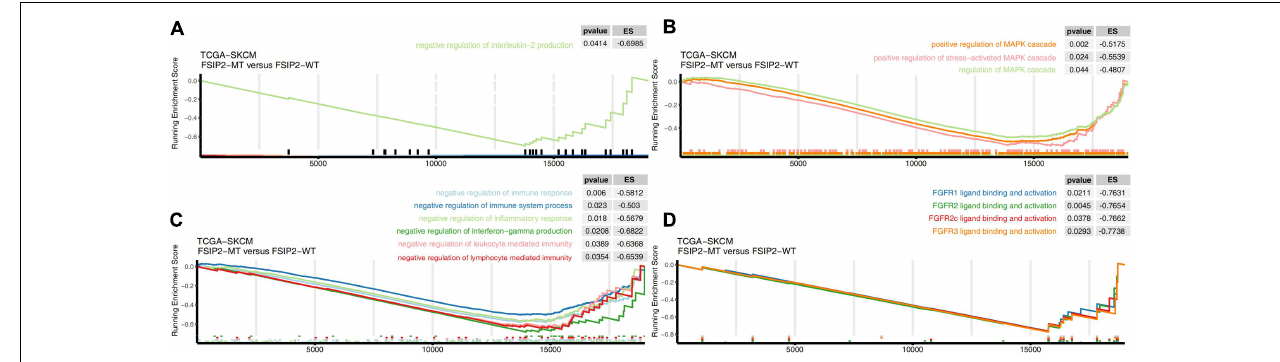
FIGURE 6 | Gene set enrichment analysis delineates biological pathways and processes associated with the efficacy of immunotherapy in TCGA-SKCM. GSEA validated the decreased activity of (A) the IL-2 synthesis negative regulation pathway, (B) the MAPK activation pathway, (C) the negative immune regulation pathway, and (D) the FGFR activation pathway in the FSIP2-MT